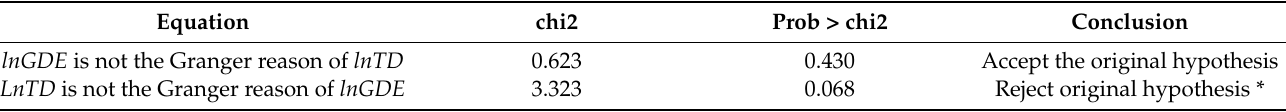
Table 4. Results of Granger causality test for TD and